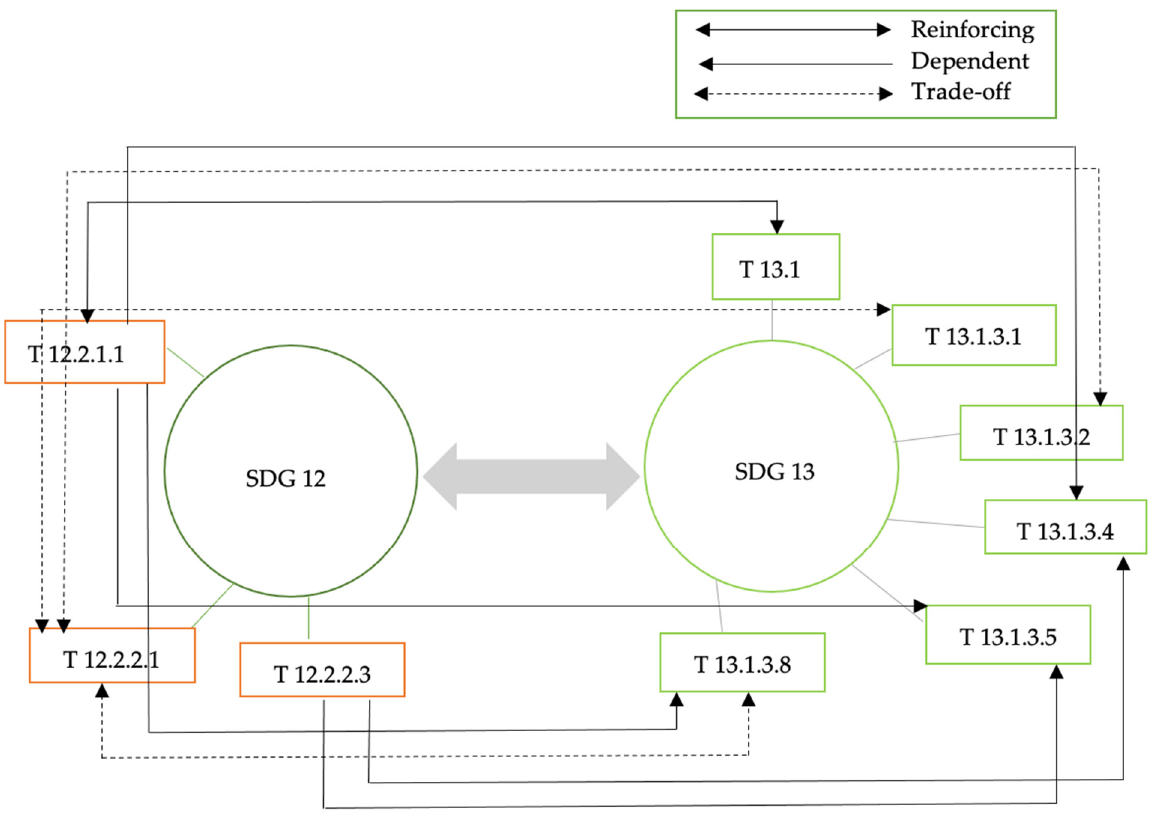
Figure 6. A conceptual linkage between SDG 12 with SDG